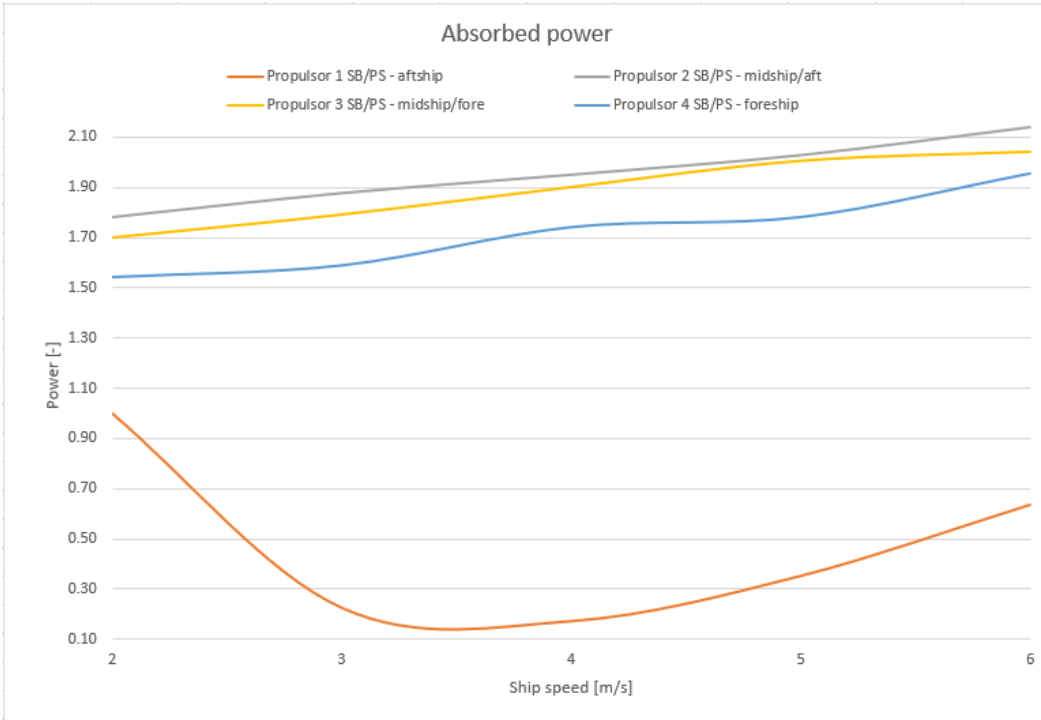
Figure 14. View of the aftship air intake zone (Layout A, shallow water). Source: Authors. The following comparative figures (Figures 15 and 16) show the thrust and power curves of three distributed propulsion layouts (C, D, E) in restricted and unrestricted water depth conditions. The thrust and power of layout A at mean speed 4 m/s in deep water have been used as unity values.